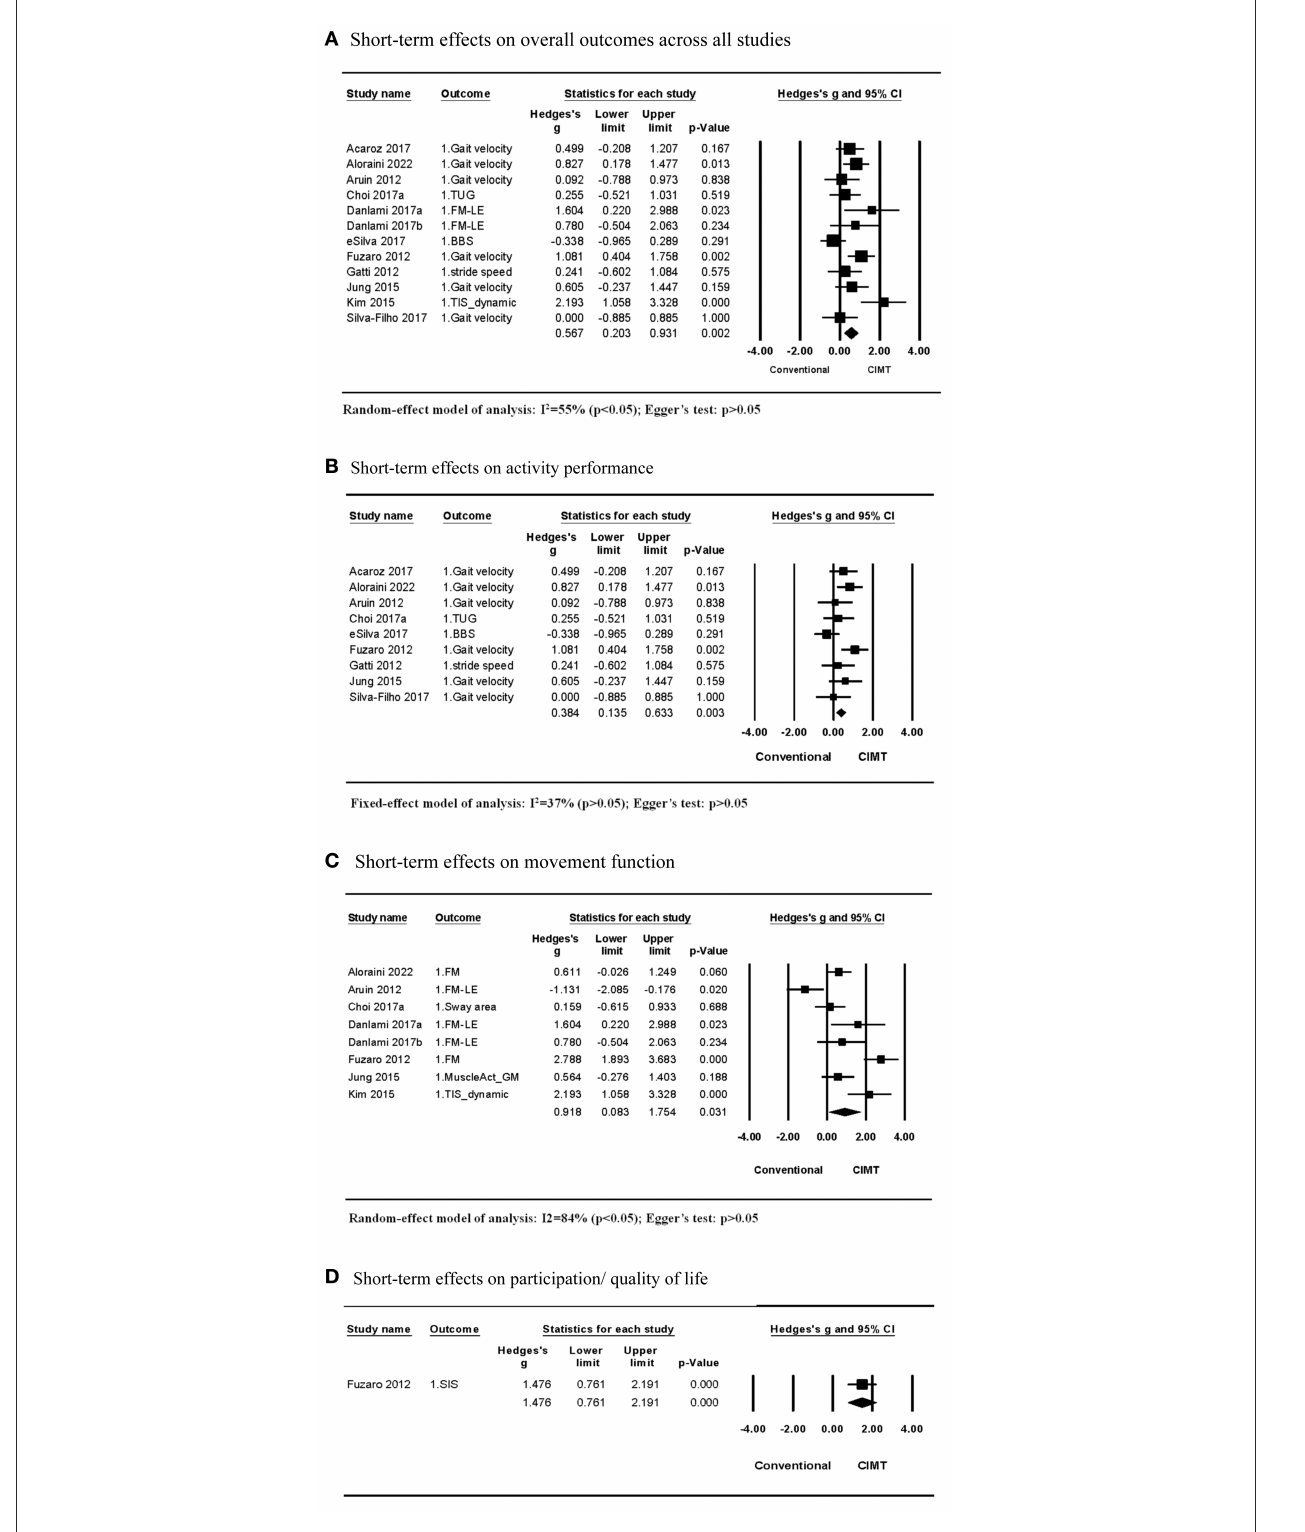
FIGURE2 Short-term effects of CIMT compared with conventional treatment. (A) Short-term effects on overall outcomes across all studies. (B) Short-term effects on activity performance. (C) Short-term effects on movement function. (D) Short-term effects on participation/quality of